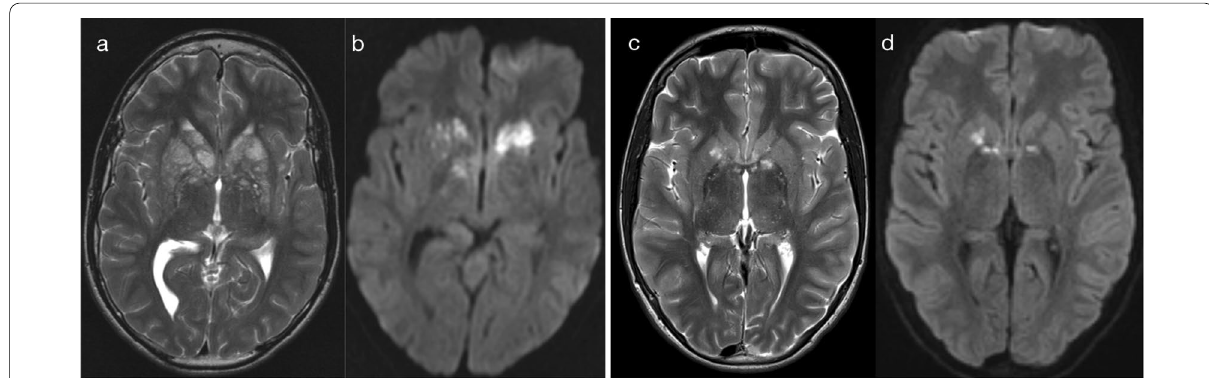
Fig. 15 T2 hyperintensity in basal ganglia and/or thalami (Pattern 5). Case 1: 15‑year‑old child with headache, nausea and vomiting. CSF was positive for cryptococcus. T2‑weighted imaging ( a ) demonstrated bubble‑like lesions within the basal ganglia (relating to gelatinous pseudocysts), with a relatively smaller component of restricted diffusion ( b ). Case 2: 14‑year‑old child with malaise for 2 weeks. CSF was positive for cryptococcus. T2‑weighted imaging ( c ) demonstrated bubble‑like lesions within the basal ganglia and thalami, with a relatively smaller component of restricted diffusion ( d )